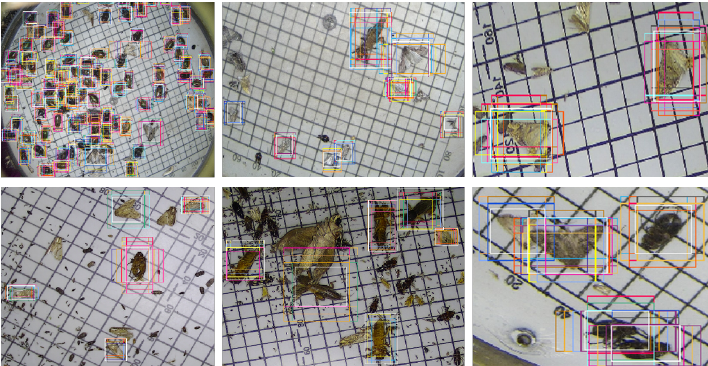
Figure 10. Illustration of the positive anchor samples (colored) in AFRPN and ground-truth boxes (white).